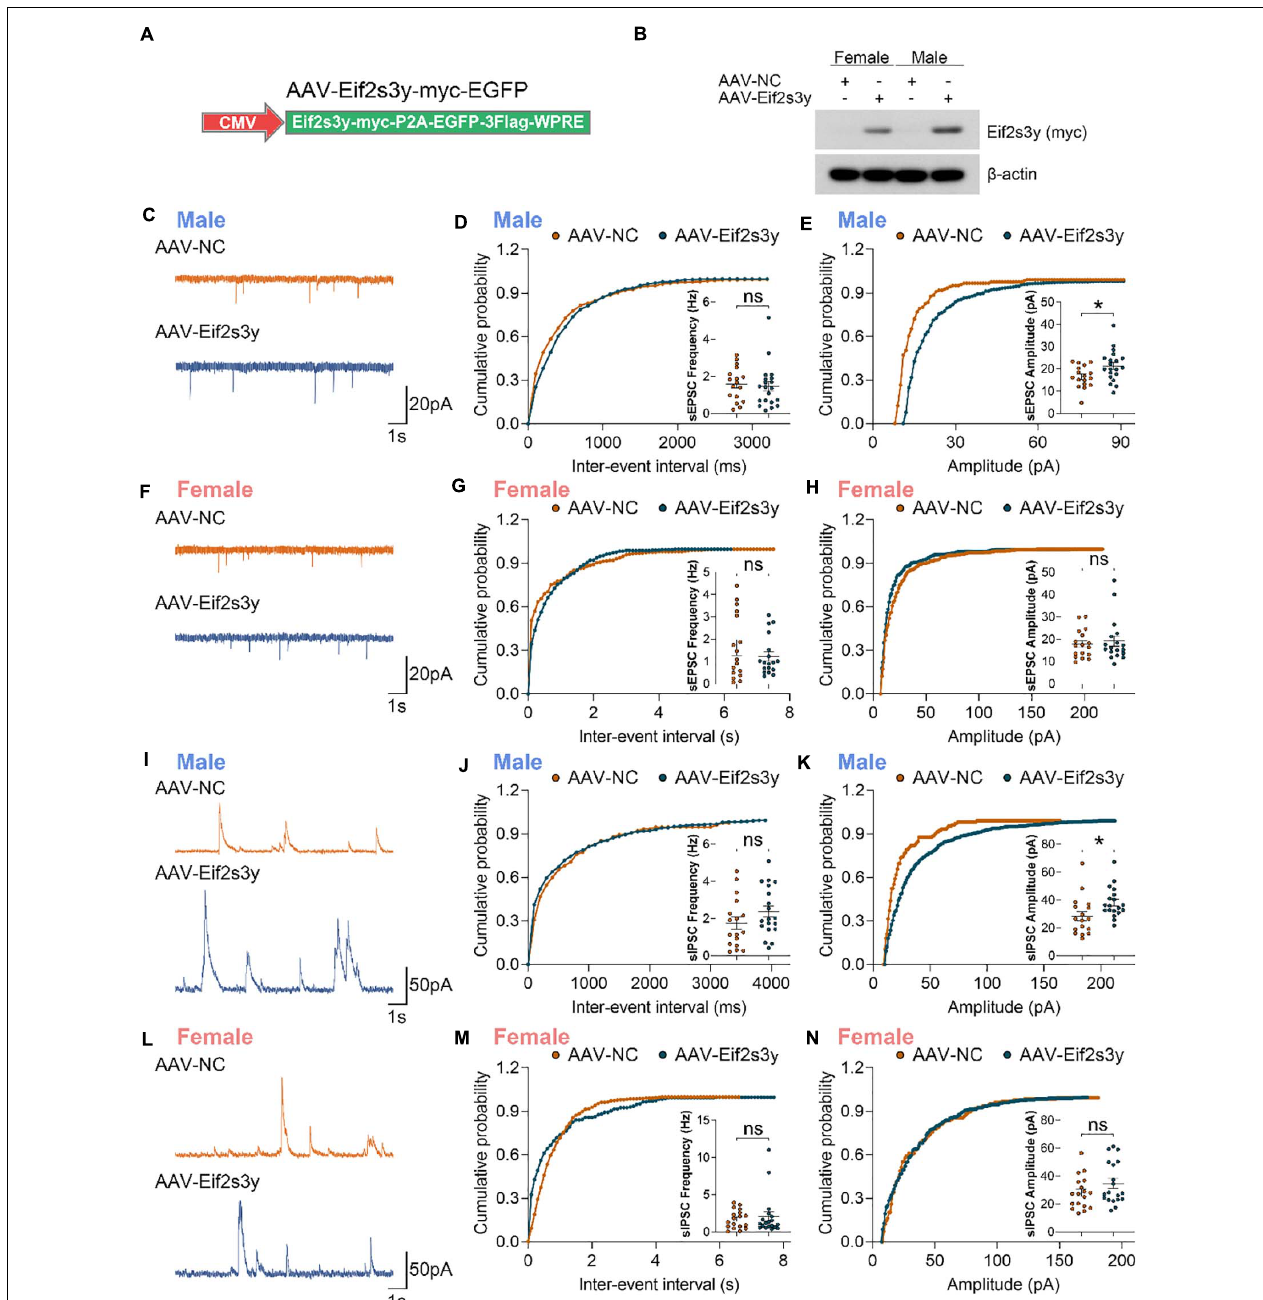
FIGURE 4 | Overexpression of Eif2s3y promotes excitatory and inhibitory synaptic transmission specifically in male neurons. (A) Scheme of the Eif2s3y-Myc expressing construct used for AAV packaging. (B) Primary neurons from E16.5 male and female mice were infected with AAV expressing Eif2s3y (AAV-Eif2s3y) or EGFP (AAV-NC). Exogenous Eif2s3y protein was detected by western blotting using an anti-Myc antibody. (C) Representative traces of sEPSCs recorded from primary male neurons infected with AAV-Eif2s3y ( n = 20 cells) and AAV-NC ( n = 17 cells). Scale bars, 20 pA (vertical) and 1 s (horizontal). (D,E) Cumulative probabilities of sEPSC frequency (D) and amplitude (E) and respective quantification and comparison in male neurons. (F) Representative traces of sEPSCs recorded from primary female neurons infected with AAV-Eif2s3y ( n = 18 cells) and AAV-NC ( n = 17 cells). Scale bars, 20 pA (vertical) and 1 s (horizontal). (G,H) Cumulative probabilities of sEPSC frequency (G) and amplitude (H) and respective quantification and comparison in female neurons. (I) Representative traces of sIPSCs recorded from primary male neurons infected with AAV-Eif2s3y ( n = 19 cells) and AAV-NC ( n = 17 cells). Scale bars, 50 pA (vertical) and 1 s (horizontal). (L,K) Cumulative probabilities of sIPSC frequency (L) and amplitude (K) and respective quantification and comparison in male neurons. (L) Representative traces of sIPSCs recorded from primary female neurons infected with AAV-Eif2s3y ( n = 19 cells) and AAV-NC ( n = 18 cells). Scale bars, 50 pA (vertical) and 1 s (horizontal). (M,N) Cumulative probabilities of sIPSC frequency (M) and amplitude (N) and respective quantification and comparison in female neurons. Mann Whitney test was used for (G,H,M) . Unpaired t -test was used for (D,E,J,K,N) . * p < 0.05, ns, not significant.